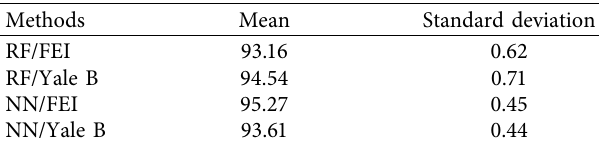
Table 8: The mean and standard deviation results for the proposed methods using the random forest and the neural network (NN) classifier with the FEI dataset and Yale